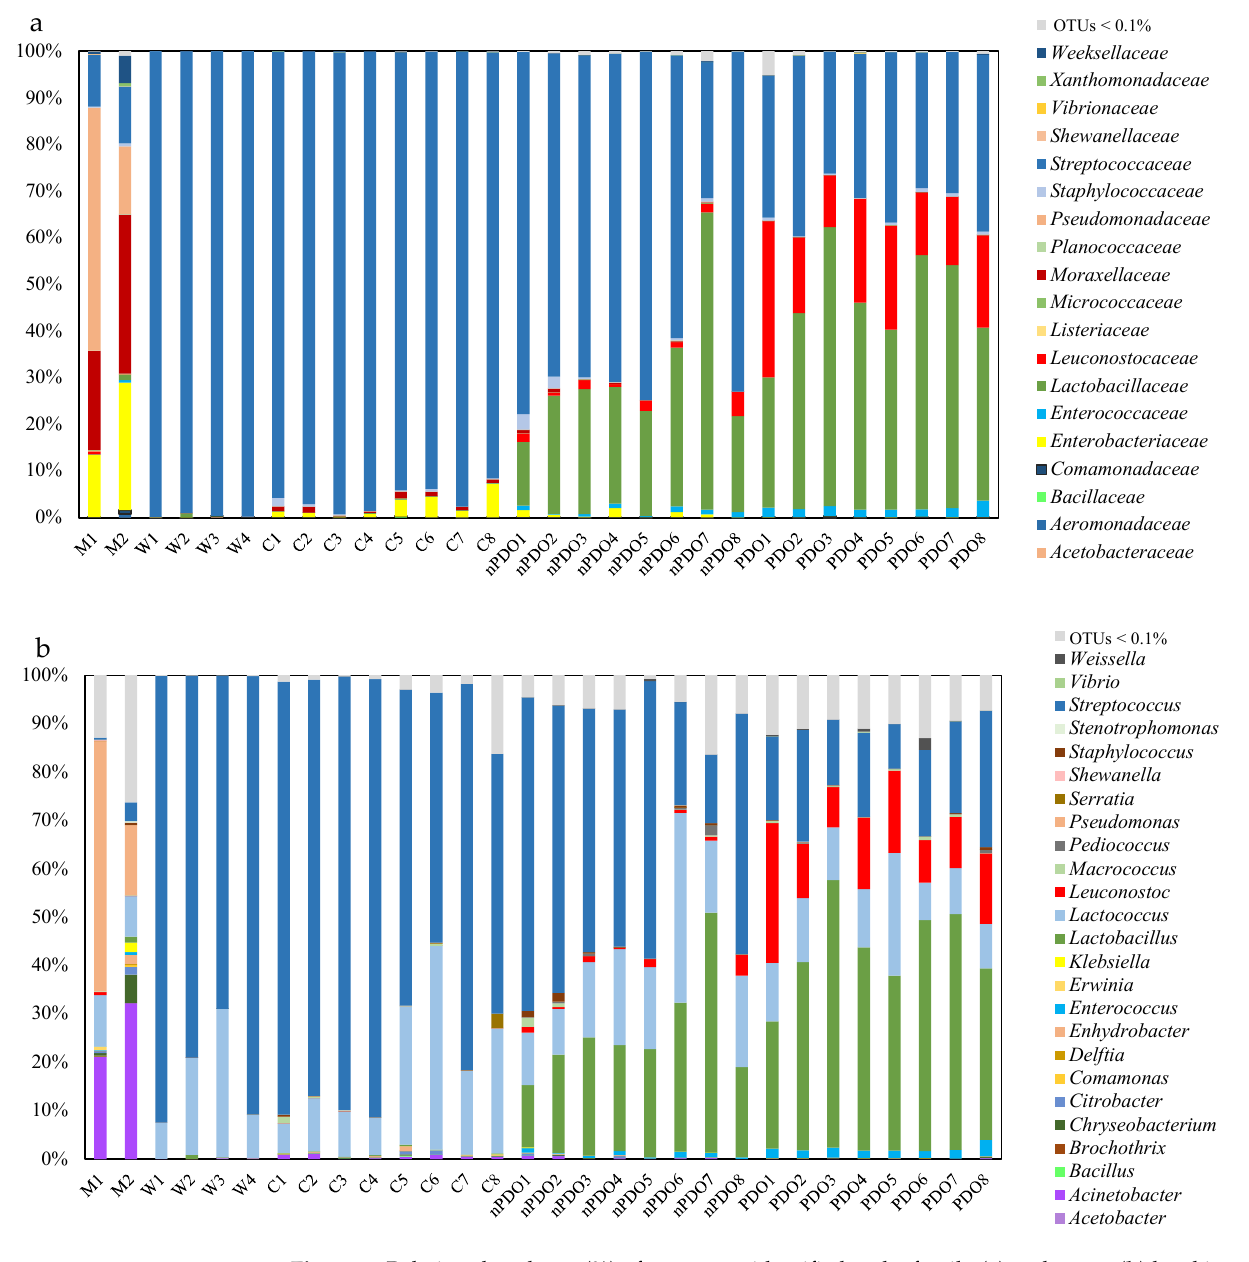
Figure 1. Relative abundance (%) of sequences identified at the family ( a ) and genus ( b ) level in milk (M), whey (W), curd (C), non-PDO cheeses (nPDO) and PDO cheeses (PDO). Only taxa contributing more than 0.1% of the total abundance in at least one sample are shown.